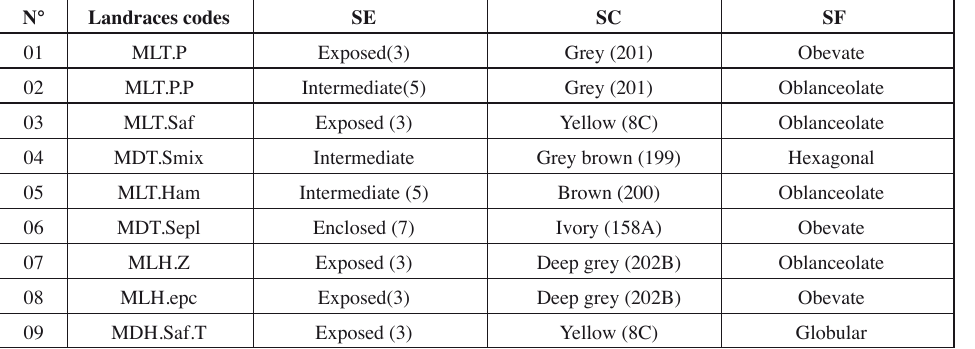
Tab. 2: Qualitative and quantitative characters of pearl millet grains.